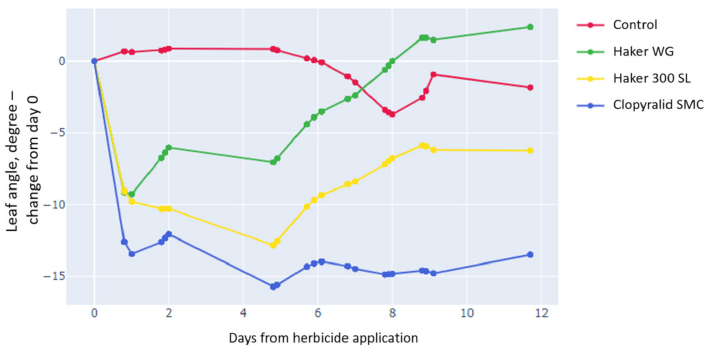
Figure 5. Dynamics of changes in the leaf angle of the cocklebur treated with various herbicides and Control plants.